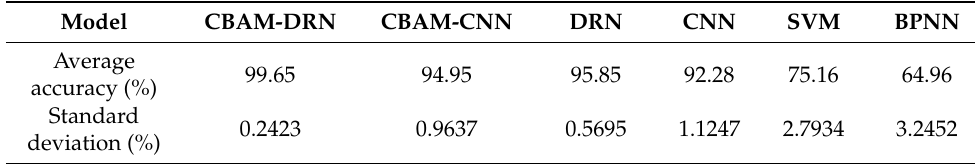
Figure 16. Diagnosis results of the 10 trials using different methods. Table 8. Experimental results of different fault diagnosis